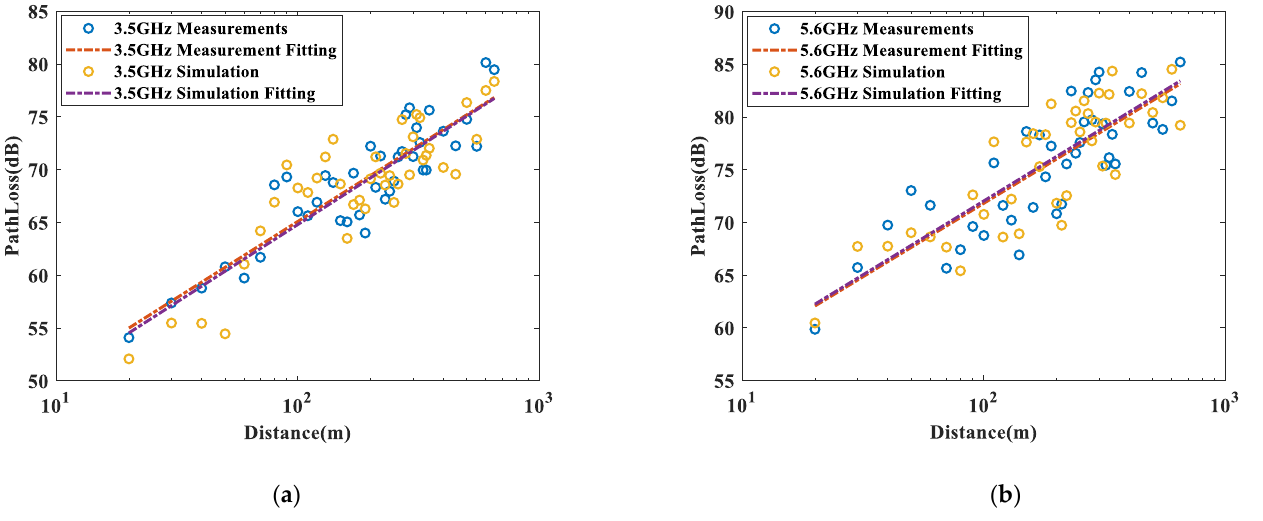
Figure 9. Comparison of path-loss results between measurement and RT simulation ( a ) 3.5 GHz ( b ) 5.6 GHz.